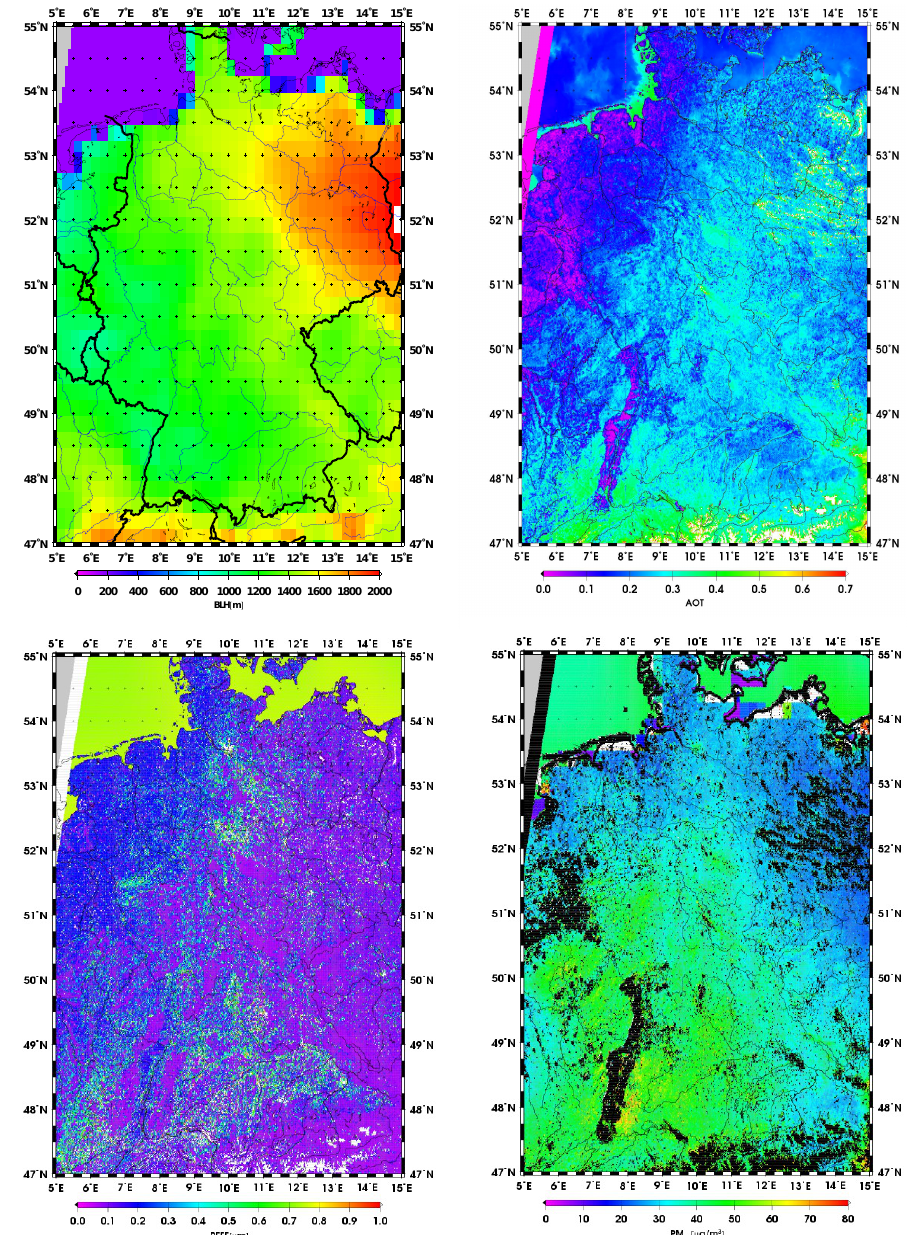
Fig. A12. E CMWF @ boundary layer height for 12 June 2006 over Germany, interpolated to 10:00 a.m., aerosol optical depth at 440nm, effective radii and PM 10 mass concentration.